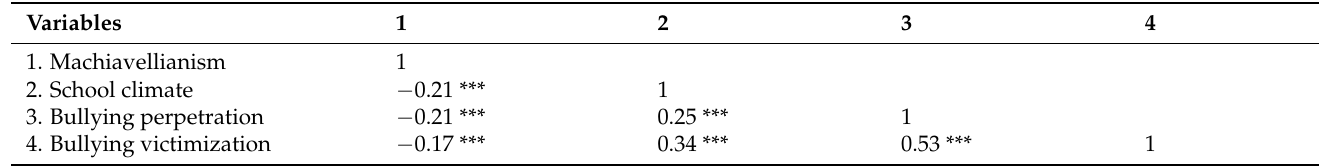
Table 2. Pearson correlation coefficients between main variables ( n = 727).